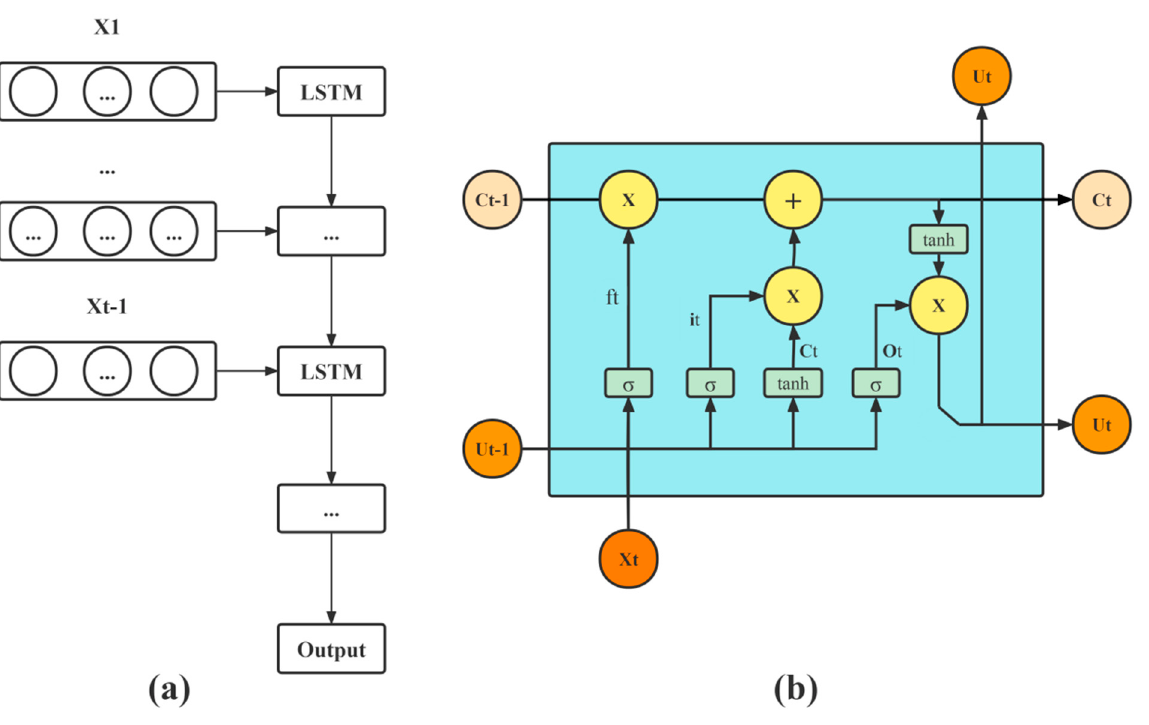
Figure 5. Schematic of the ( a ) framework for the long short-term memory (LSTM) to simulate pollutant concentrations and ( b ) LSTM cell structure.